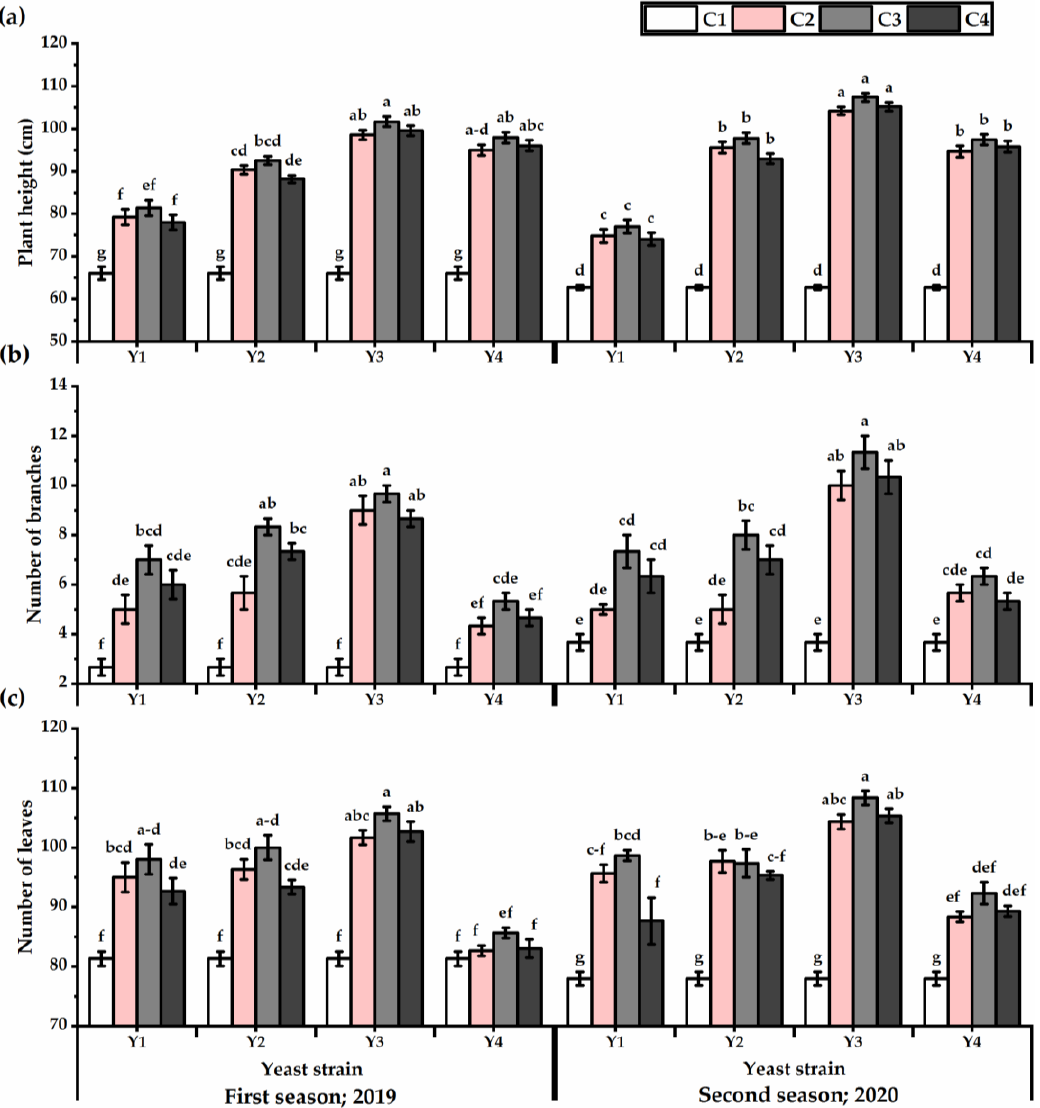
Figure 1. Plant height (cm) ( a ), number of branches ( b ), and number of leaves ( c ) of Plectranthus amboinicus (Lour.) Spreng. plants subjected to Rhodotorula muciligenese (Y1), Candida sake (Y2), Candida apicola (Y3), and Candida kunwiensis (Y4) yeast strains foliar application at 0 (C1), 1 × 10 4 (C2), 1 × 10